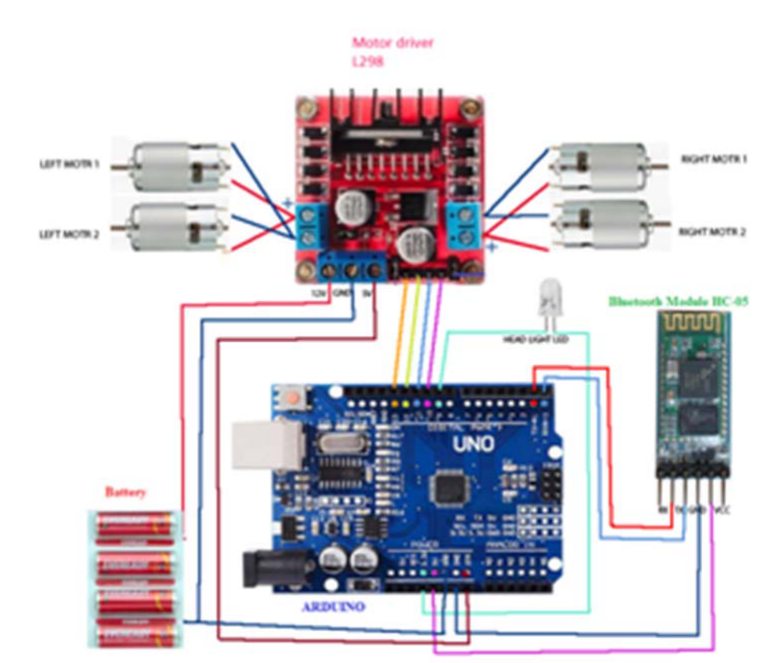
Figure 1. Block diagram of proposed system.